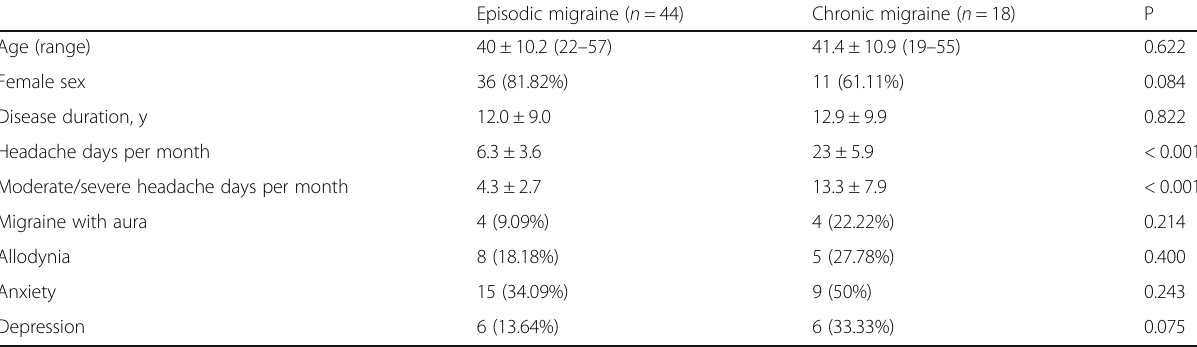
Table 1 Demographics and characteristics of study participants